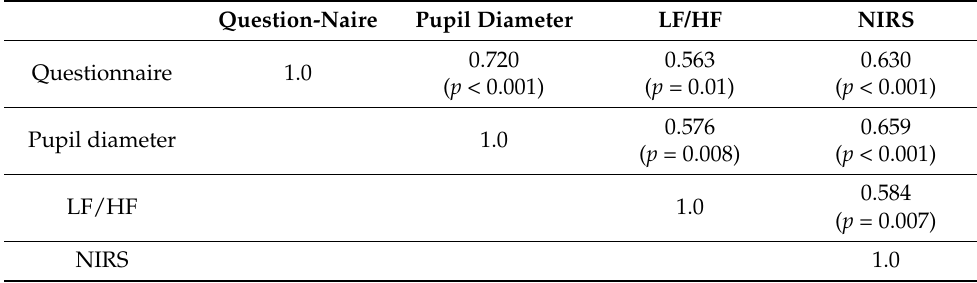
Table 1. Correlation coefficient between each measurement method. Question-naire Pupil diameter